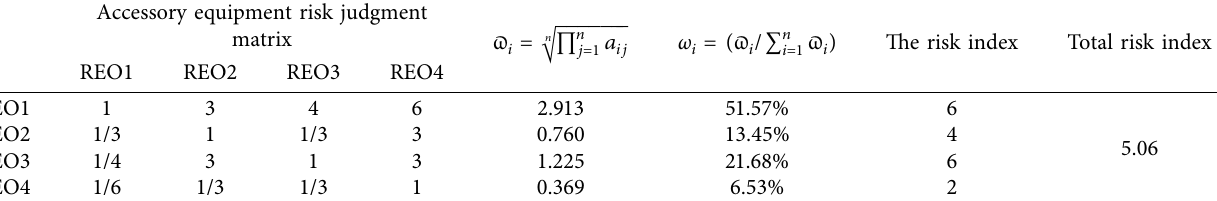
Table 35: Accessory equipment risk judgment matrix.